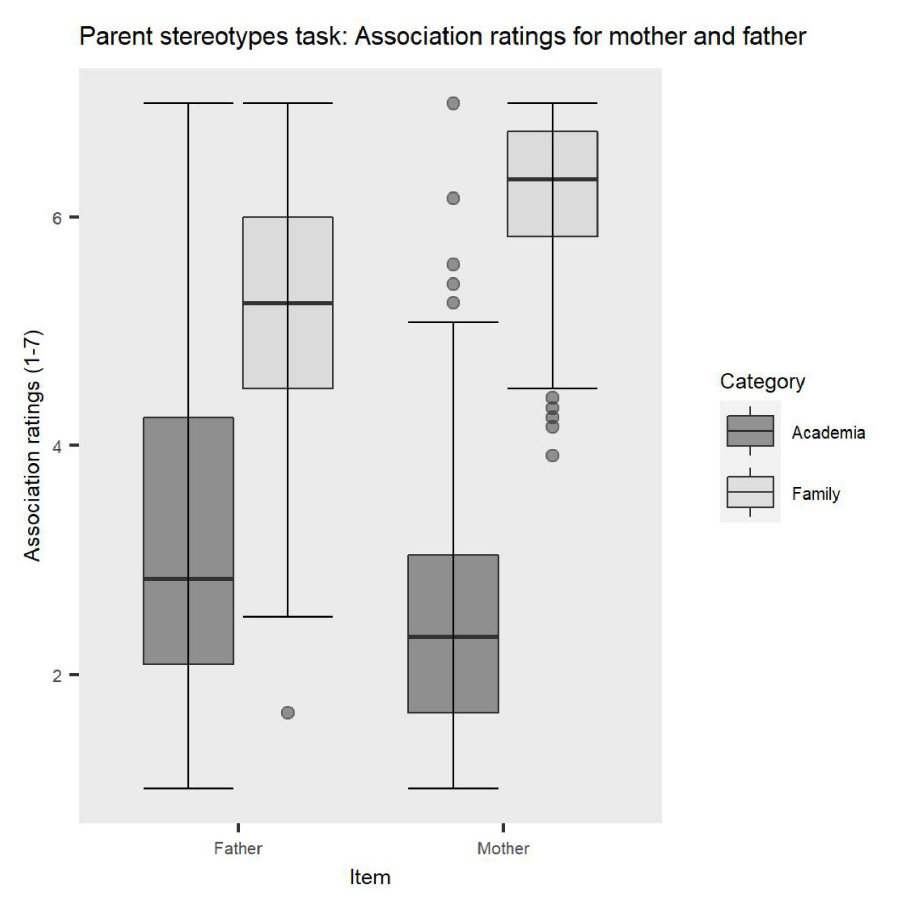
Fig 1. Significant interaction between item and category, showing differences in participants’ associations between mothers/fathers and academia/family.